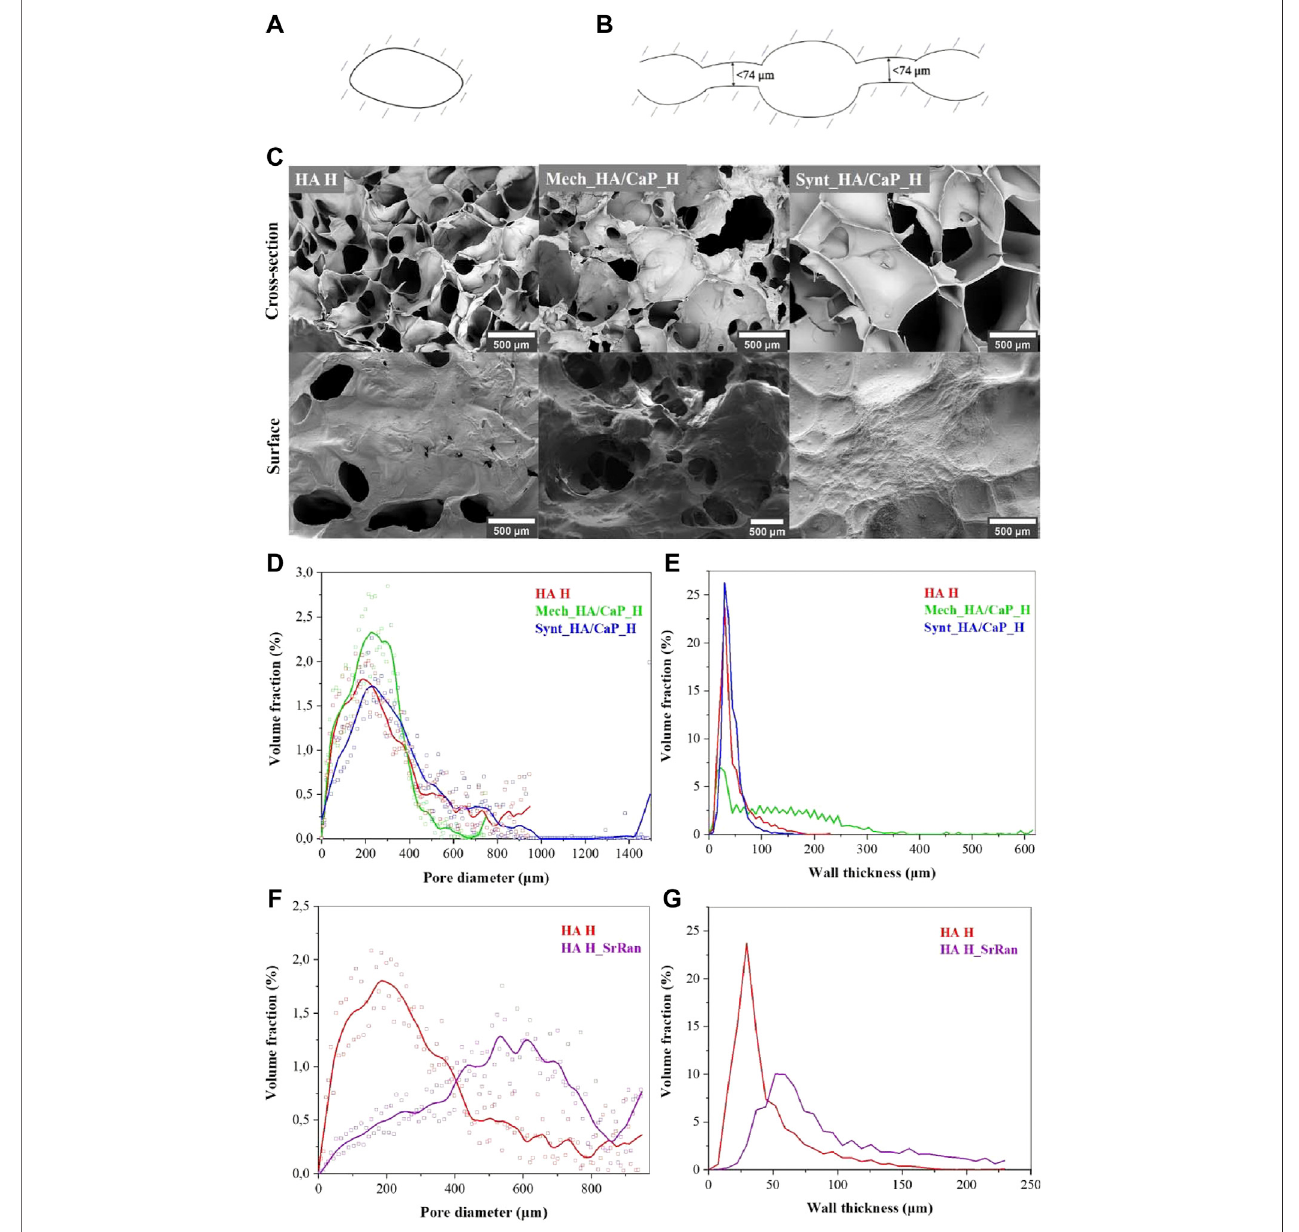
FIGURE3| CharacterizationofHA-containinghydrogelmicrostructure. (A) Illustrationofclosedporesunclonablebybonecells; (B) illustrationofslightlyconnected pores unclonable by bone cells; (C) SEM microphotographs of HA-containing hydrogels; (D) pore volume fraction as a function of pore size in the lyophilized hydrogels; (E) volume fraction of pore walls as a function of wall thickness in the lyophilized hydrogels; (F) pore volume fraction as a function of pore size in the lyophilized HA and HA_SrRan hydrogel; (G) volume fraction of pore walls as a function of wall thickness in the lyophilized HA and HA_SrRan hydrogel.